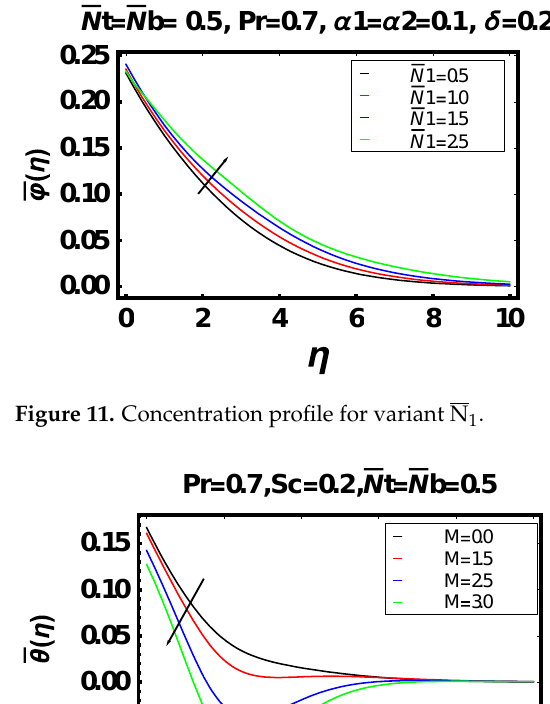
Figure 13. Mass Concentration profile for variant M .